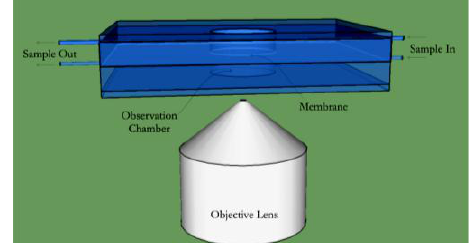
FIGURE 1: Diagram of prototype device. The observation chamber contains the sample of interest and the contents of the chamber above can be changed to affect the sample in the observation chamber by diffusion of salt, for example, across the membrane separating the two chambers. Rheological changes can be observed in real-time through the use of the Optical Tweezers.